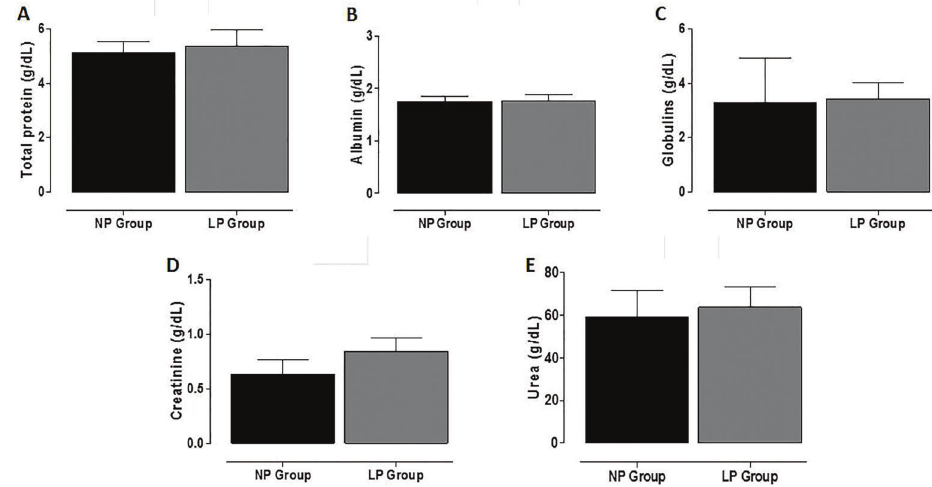
Figure 1. Serum biochemical parameters. Total protein ( panel A ), albumin ( panel B ), globulins ( panel C ), creatinine ( panel D ), and urea ( panel E ) of female rats subjected to a normal- (NP group, 17% protein) or low-protein diet (LP group, 8% protein) during pregnancy. Data are reported as means ± SE and the comparison between groups was done by unpaired Student ’ s t -test (P 4